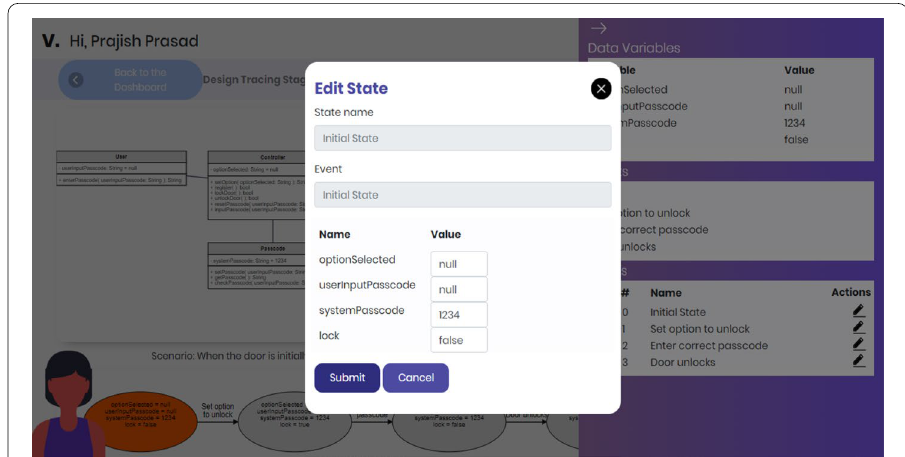
Fig. 6 In Challenge 2, learners can change values of variables in appropriate